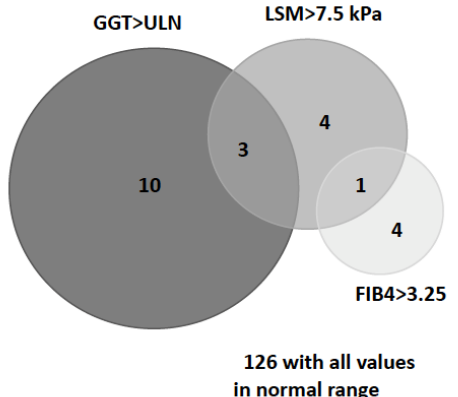
Figure 3. Relation between elevated GGT, FIB4, and LSM in Pi*ZZ patients. GGT: Gamma-glu- tamyl transferase; FIB-4: Fibrosis 4; LSM: Liver stiffness measurement; UPL: Upper limit of